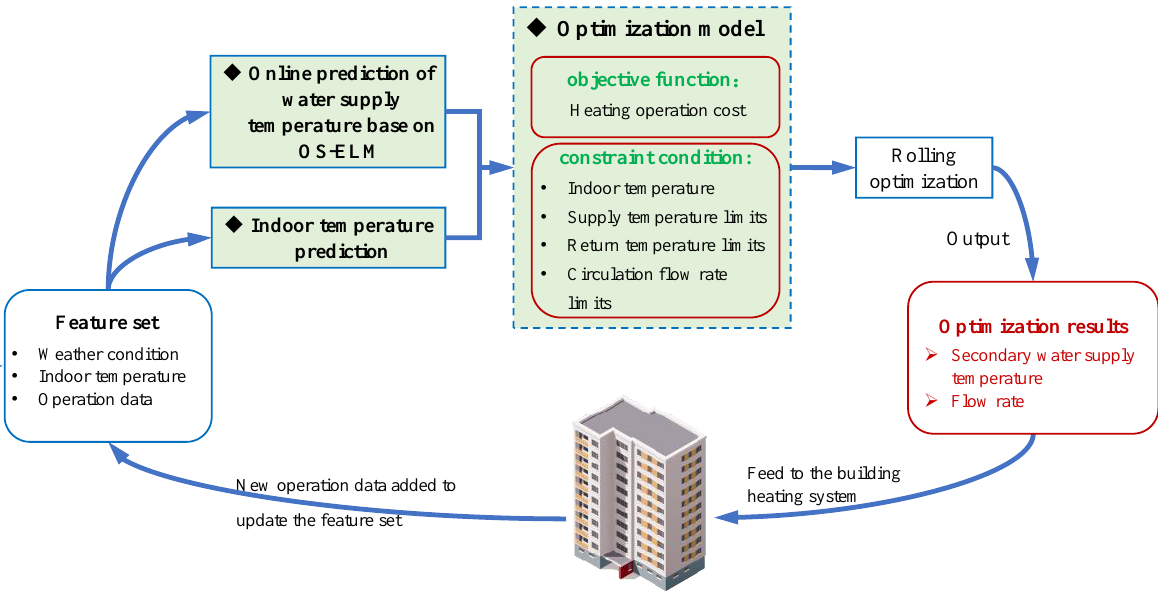
Figure 2. Optimization process framework of the integrated control of the heating system. (1) Parameters such as outdoor temperature, characteristic room temperature and